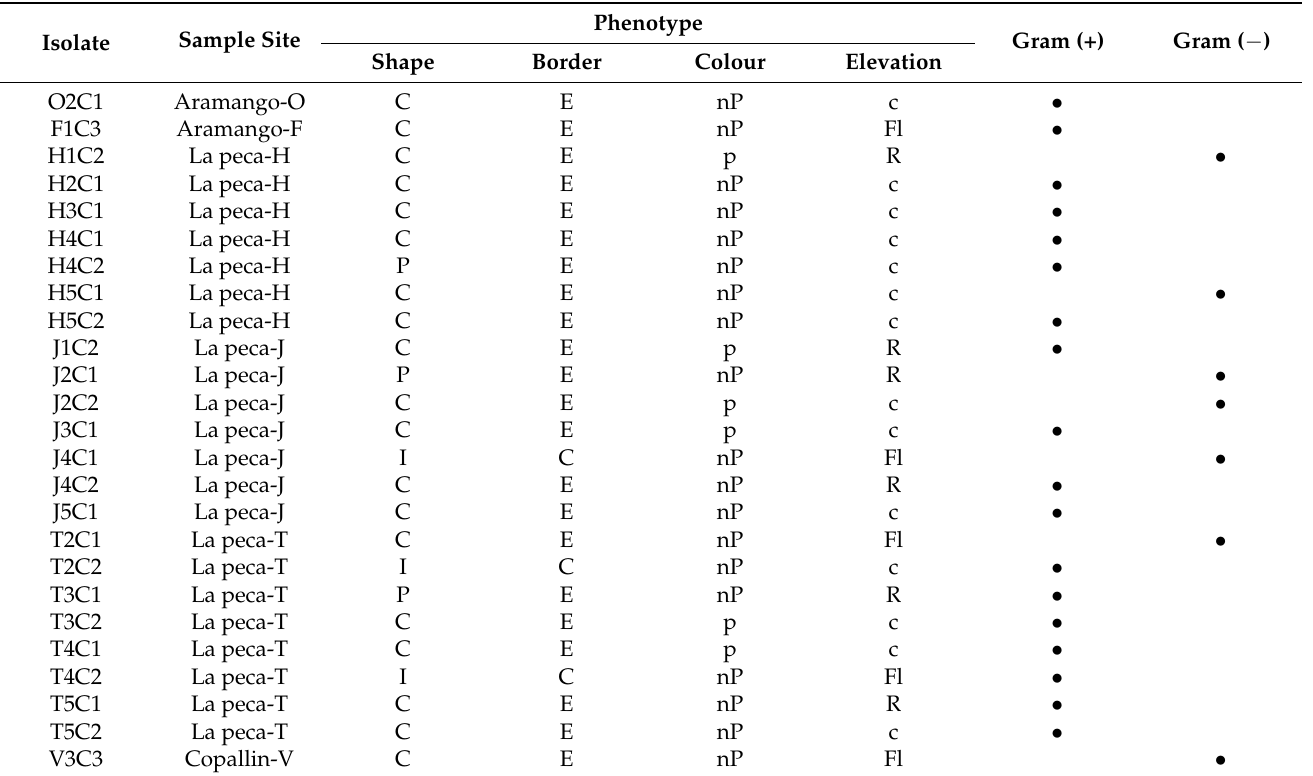
Table 1. Phenotypic characterization of cadmium-resistant bacteria associated with cacao. Isolate Sample